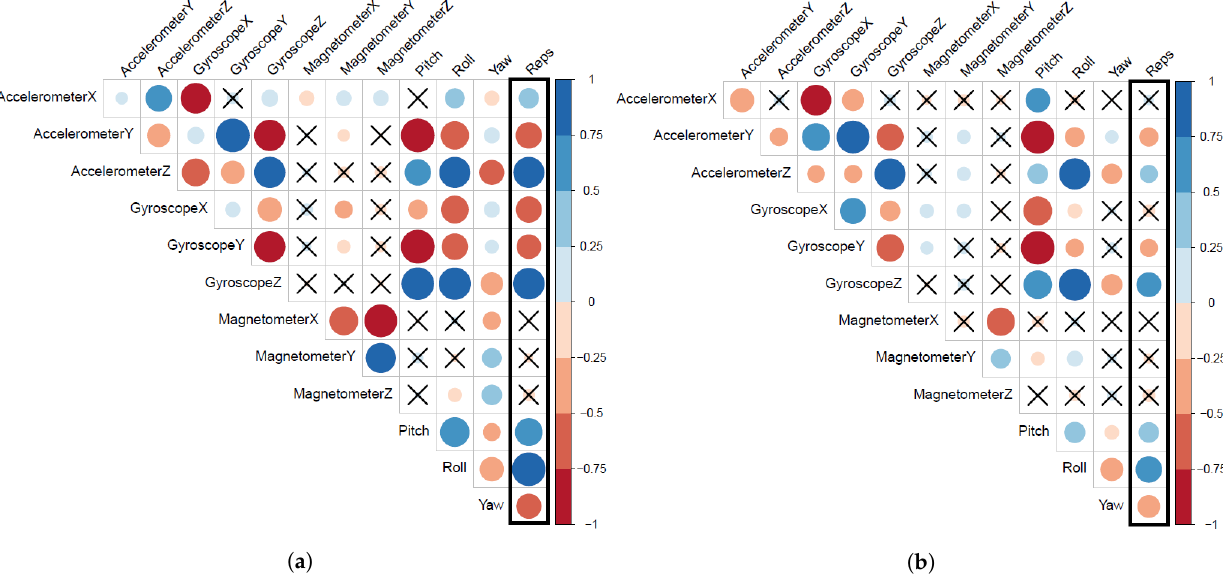
Figure 7. Graphical display of the differences in the correlation matrices of the 12 extracted features (mean) and the bicep repetitions with and without fatigue. ( a ) Correlation matrix of the 12 mean features and the bicep repetitions in the non-fatigue subset. ( b ) Correlation matrix of the 12 mean features and the bicep repetitions in our complete